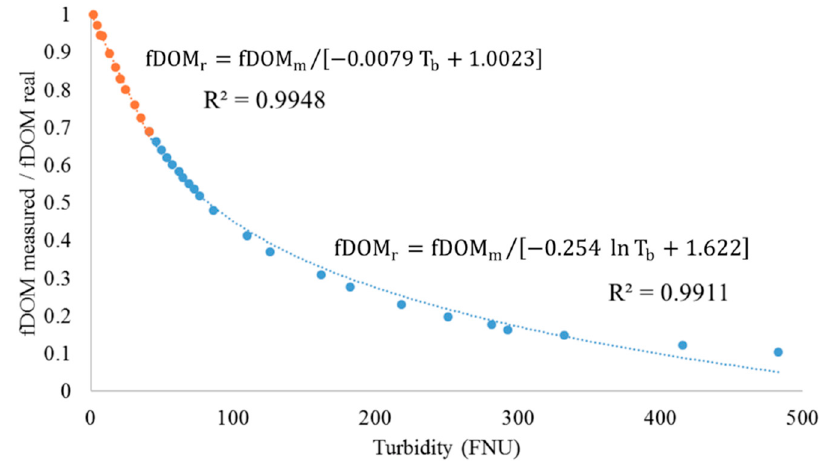
Figure 3. Behavior of fluorescence intensity across the turbidity range.